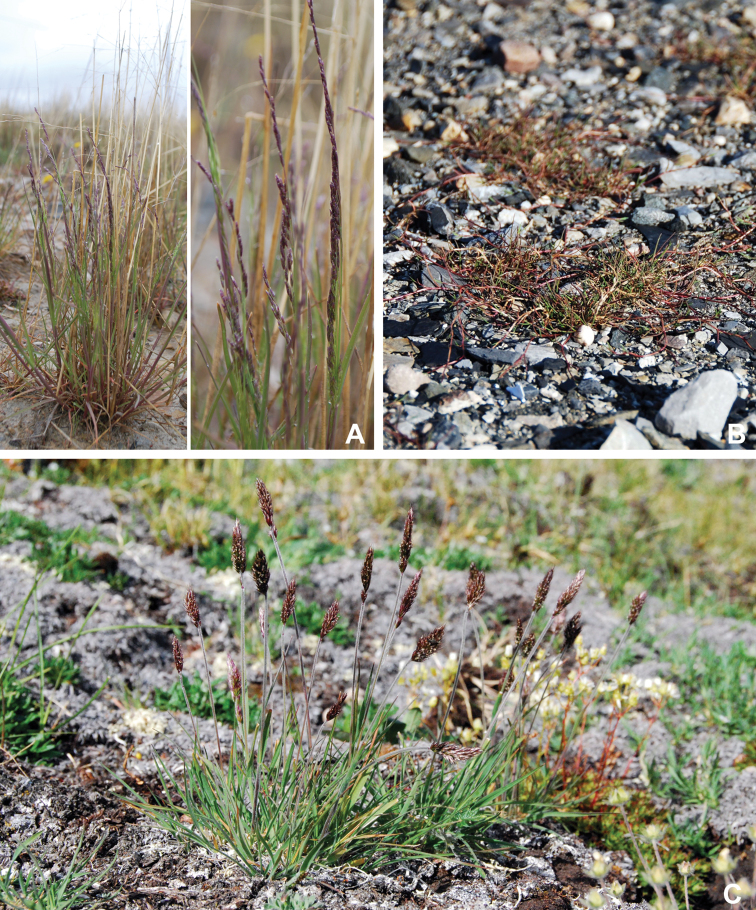
APuccinellia
nuttalliana habit (left) and inflorescences (right) BPuccinellia
phryganodes
subsp.
neoarctica habit, Gillespie et al. 9644jCTrisetum
spicatum habit, Gillespie et al. 10092. Photos A by B.A. Bennett and B, C by J.M. Saarela.